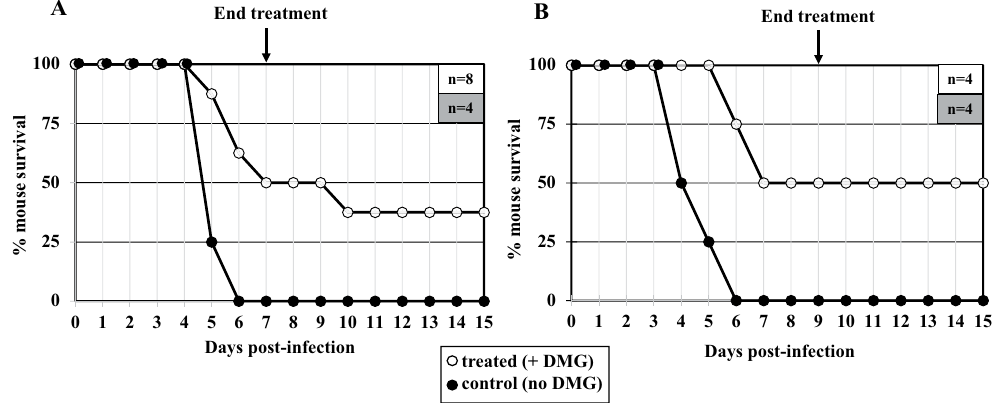
Figure 3. DMG-chelation attenuates S . Typhimurium 14028 virulence in mice. Mouse survival following infection with S . Typhimurium 14028 and treatment with DMG (white circles) or no DMG treatment (black circles). For DMG-treated mice, a dose of 3 mg DMG (in water) was orally given 6 h after infection with S .T. and then once daily, until day 7 (Panel A) or until day 9 (Panel B) post-inoculation. The last day of DMG treatment is indicated by an arrow, and the number of mice (n) used for each experiment is shown in the upper right box.